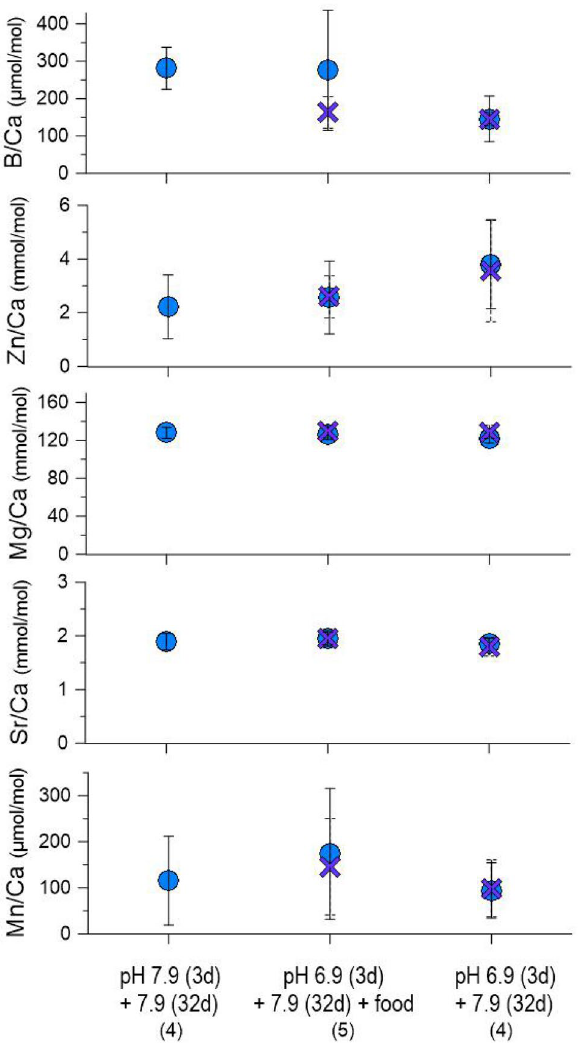
Figure 5. Average trace elements ratios measured on the F (blue circles) and F-1 (purple crosses) Peneroplis spp. chambers precipitated during the recovery phase of experiment 1. The number of specimens is indicated for each decalcification treatment. Note that the specimens from the reference pH 7.9 conditions built only one new chamber during the recovery phase, while an average of 4 and 2 chambers were built for the decalcification treatments pH 6.9 + food and pH 6.9 without food,